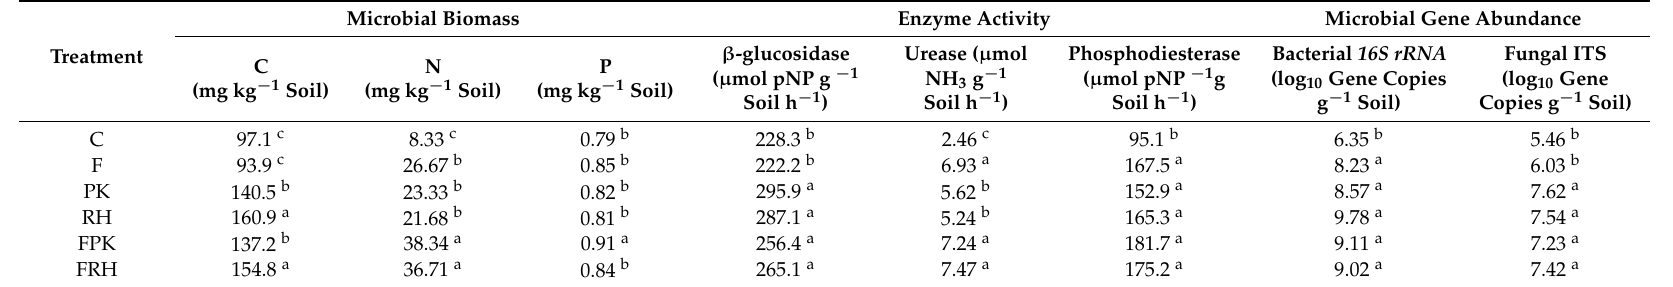
Table 3. Soil microbial biomass, enzyme activity and gene abundance after the 75 day of